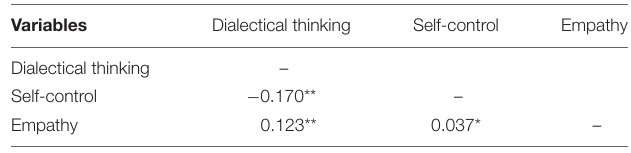
TABLE 4 | Two-variable correlation